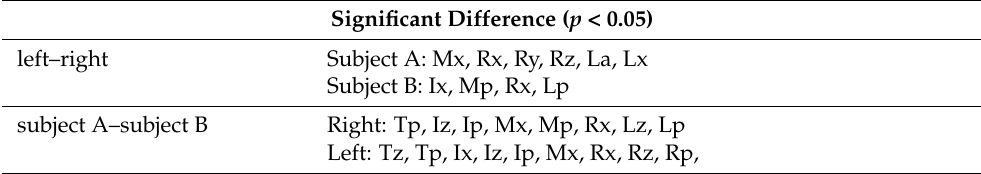
Table 3. Results of the significance difference test (left–right by subject, each subject is by right and